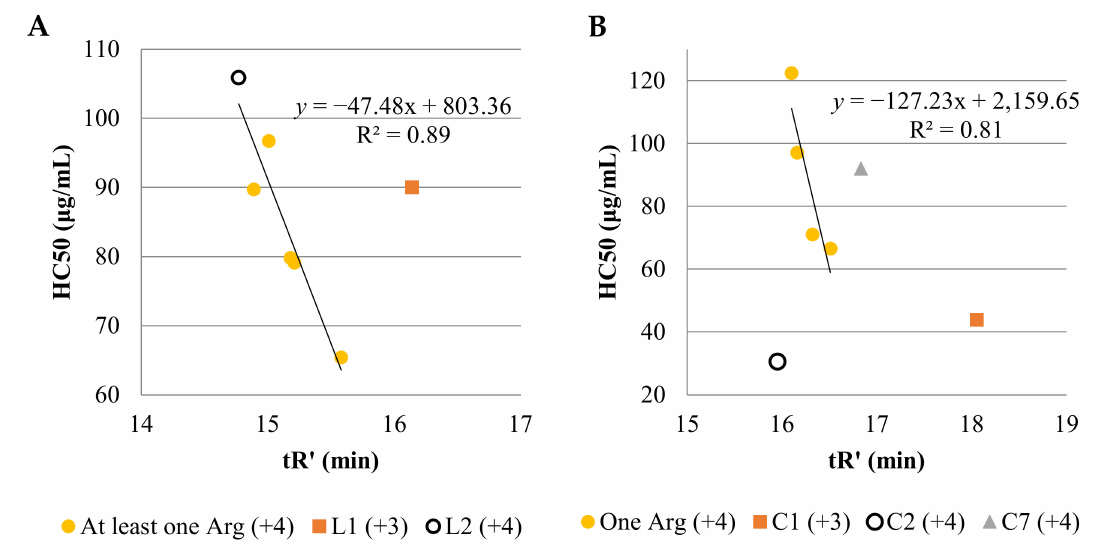
Figure 3. Hemolysis of—linear ( A ) and cyclic ( B ) USCLs vs. adjusted retention time. ( A ) At least one Arg (compounds L3 , L4 , L5 , L6 , L7 )—linear correlation; ( B ) one Arg (compounds C3 , C4 , C5 , C6 )—linear